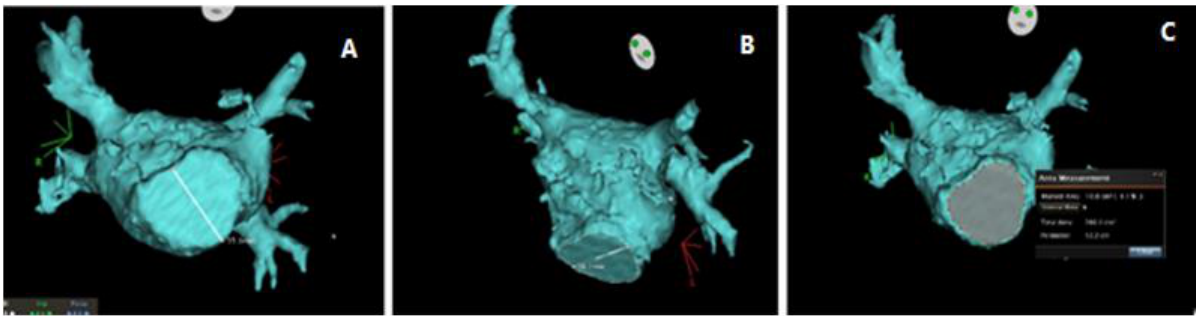
Figure 1. Diameters of the mitral annulus are depicted in the image. With red color indicating transverse diameter; with green color indicating longitudinal diameter.